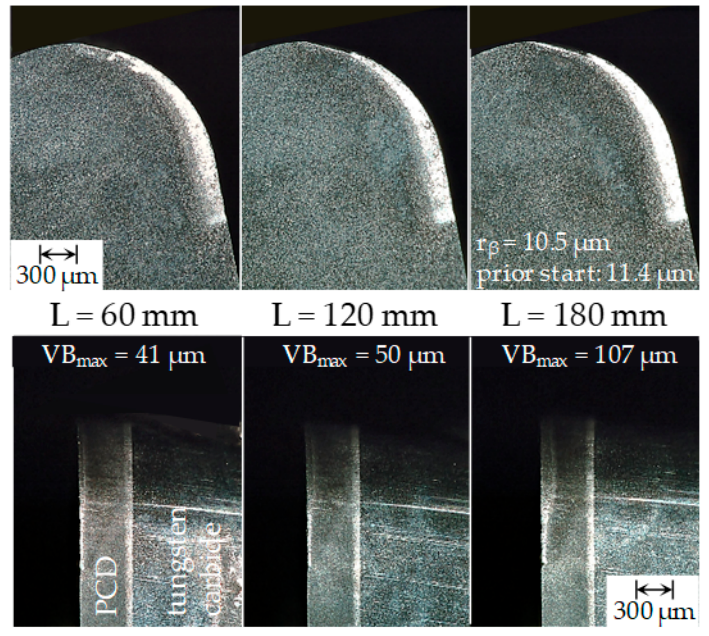
Figure 10. PCD cutting insert (mainly internal cooling, flow rate internal cooling of 1200 mL/min).